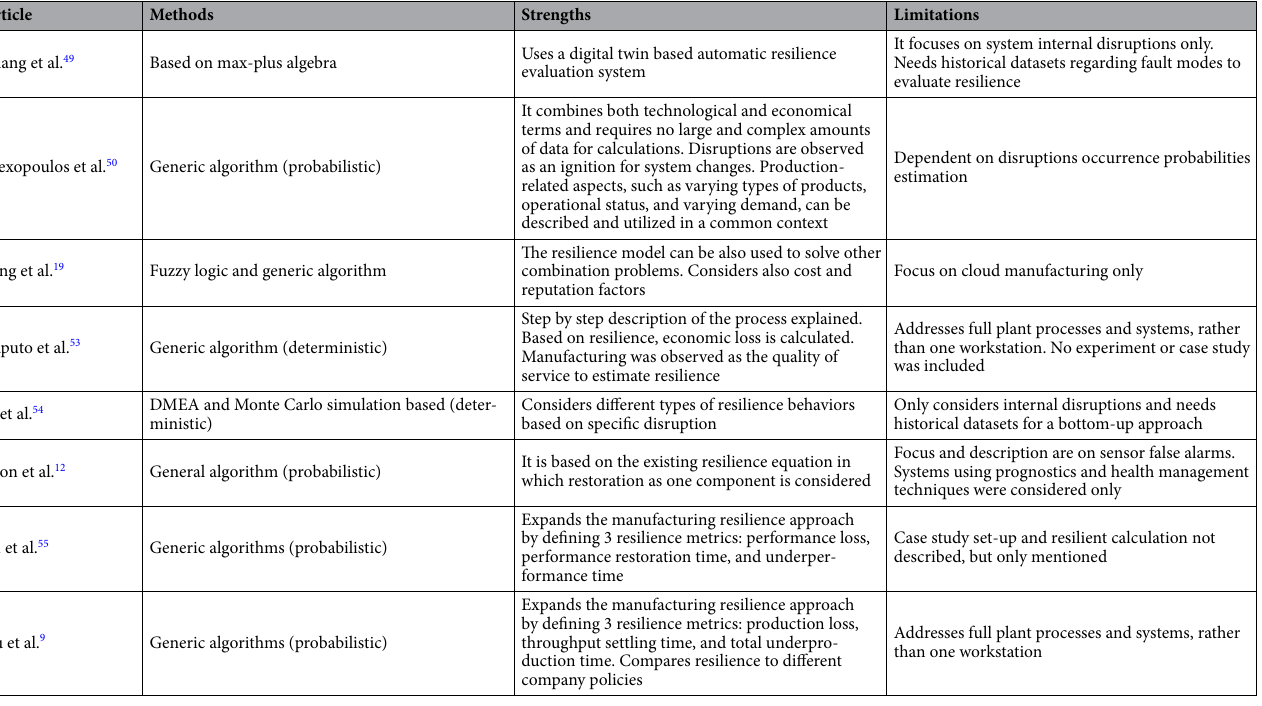
Table 5. Comparison of resilience metrics based on quantification methods, strengths, and